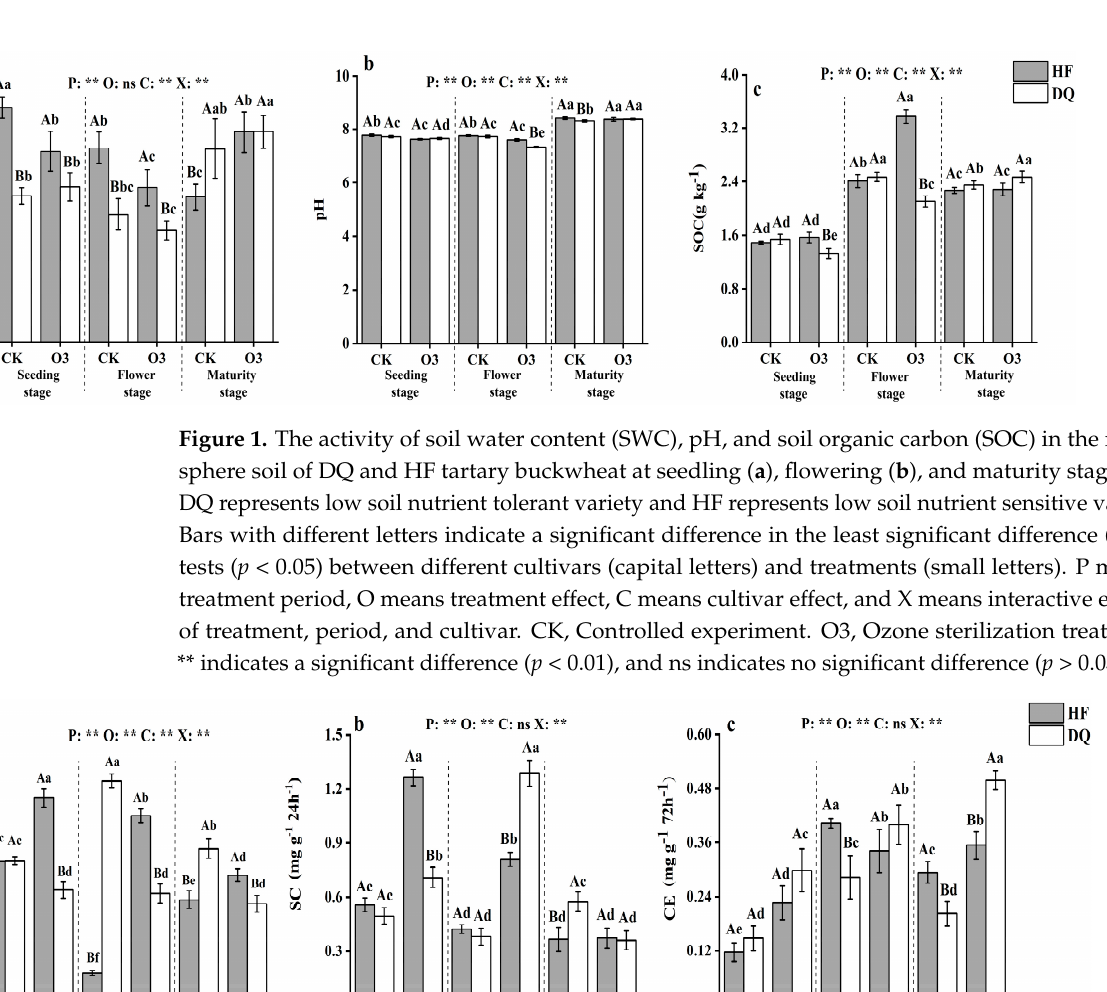
Figure 2. Activity of β− glucosidase, sucrase, and cellulases in rhizosphere soil of DQ and HF tartary buckwheat at seedling ( a ), flowering ( b ), and maturity stages ( c ). BG, β− glucosidase; SC, sucrase enzyme; CE, celluase enzyme. DQ represents low soil nutrient tolerant variety and HF represents low soil nutrient sensitive variety. Bars with different letters indicate a significant difference in the least significant difference (LSD) tests ( p < 0.05) between different cultivars (capital letters) and treat- ments (small letters). P means samples period effects, O means germicidal treatment effects, C means variety effects, and X means the interactive effects of treatments, period, and variety. CK, Controlled experiment. O3, Ozone sterilization treatment. ** indicates a significant difference ( p < 0.01), and ns indicates no significant difference ( p > 0.05).